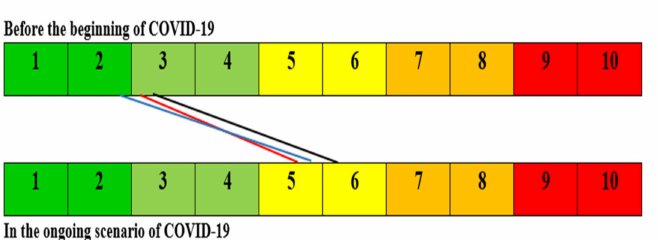
Figure 3. Self-reported levels of acute stress among respondents per socio-economic earning cate- gory during the ongoing COVID-19 pandemic, Nigeria. (Note that: 1 = no stress and 10 = much stressed [33]. Black line represents the low-income earners, red line the middle-income earners, and blue line the high-income earners. There was significant acute stress observed in each category: low-income earners (n = 289) (slide from 3.28 ± 1.68 to 6.21 ± 2.03, p value < 0.0001); middle-income earners (n = 87) (slide from 3.18 ± 1.88 to 5.53 ± 2.47, p value < 0.0001); high-income earners (n = 16) (slide from 2.89 ± 1.41 to 5.72 ± 2.52, p value <